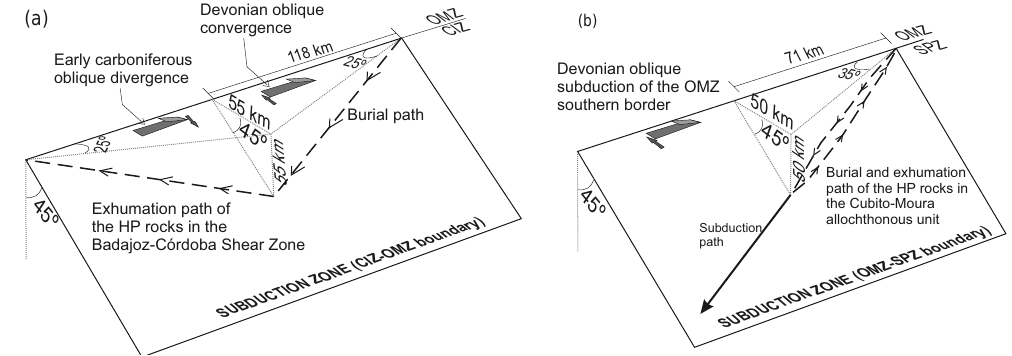
Figure 3. Simple models of burial and exhumation for the high-pressure rocks cropping out at the two collisional boundaries of the OMZ. (a) CIZ–OMZ boundary. (b) OMZ–SPZ boundary. See text for more